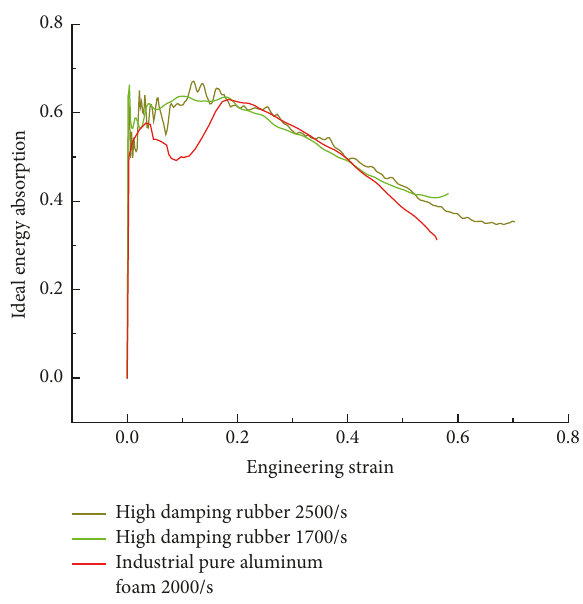
Figure 14: Comparison of ideal curve of energy absorption effi- ciency.